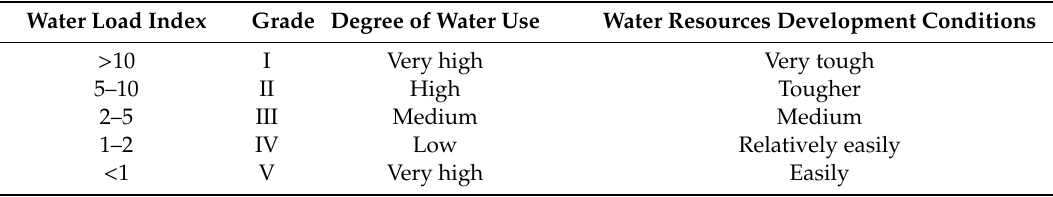
Table 2. Water load index classification.